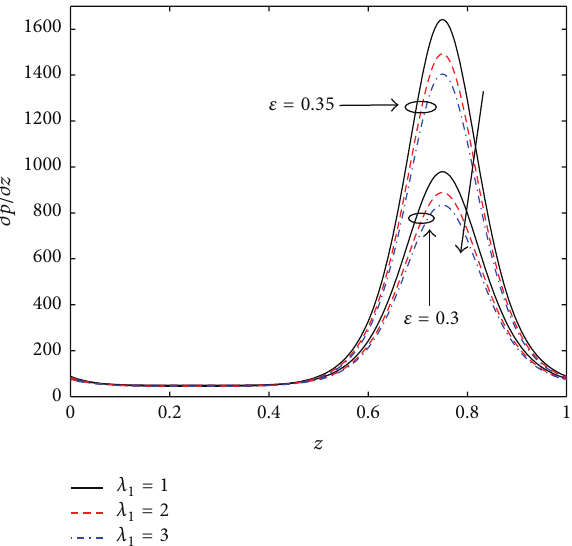
Figure 2: Pressure gradient 𝜕𝑝/𝜕𝑧 versus axial distance 𝑧 for differ- ent values of the relaxation time 𝜆 1 and radius ratio 𝜀 with 𝑄 = −2 , Gr = 3 , 𝛼 1 = 0.4 , 𝛽 = 10 , 𝜙 = 0.4 , and 𝑡 = 1